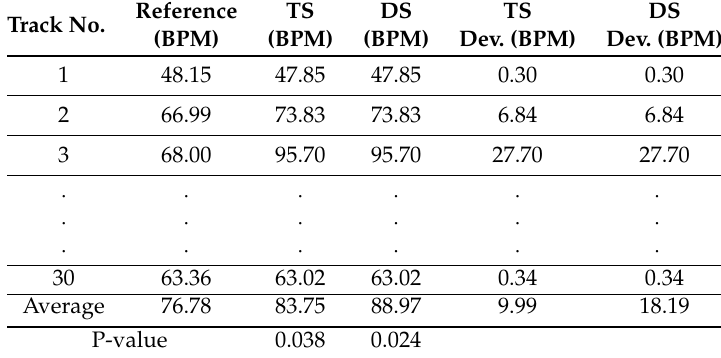
Table 3. Reference GT and computed GT of the reference database.